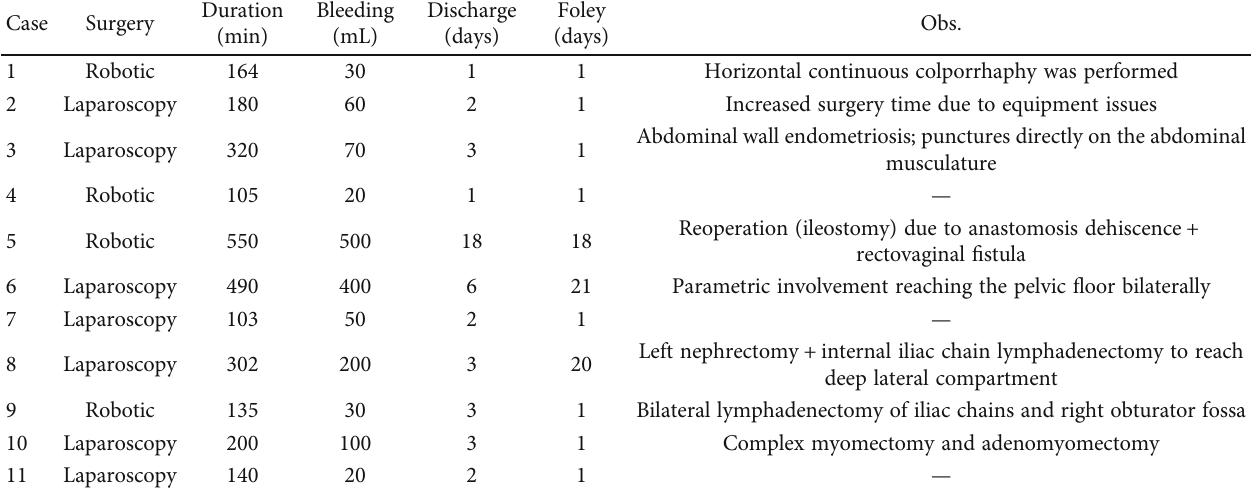
Table 2: Details of the